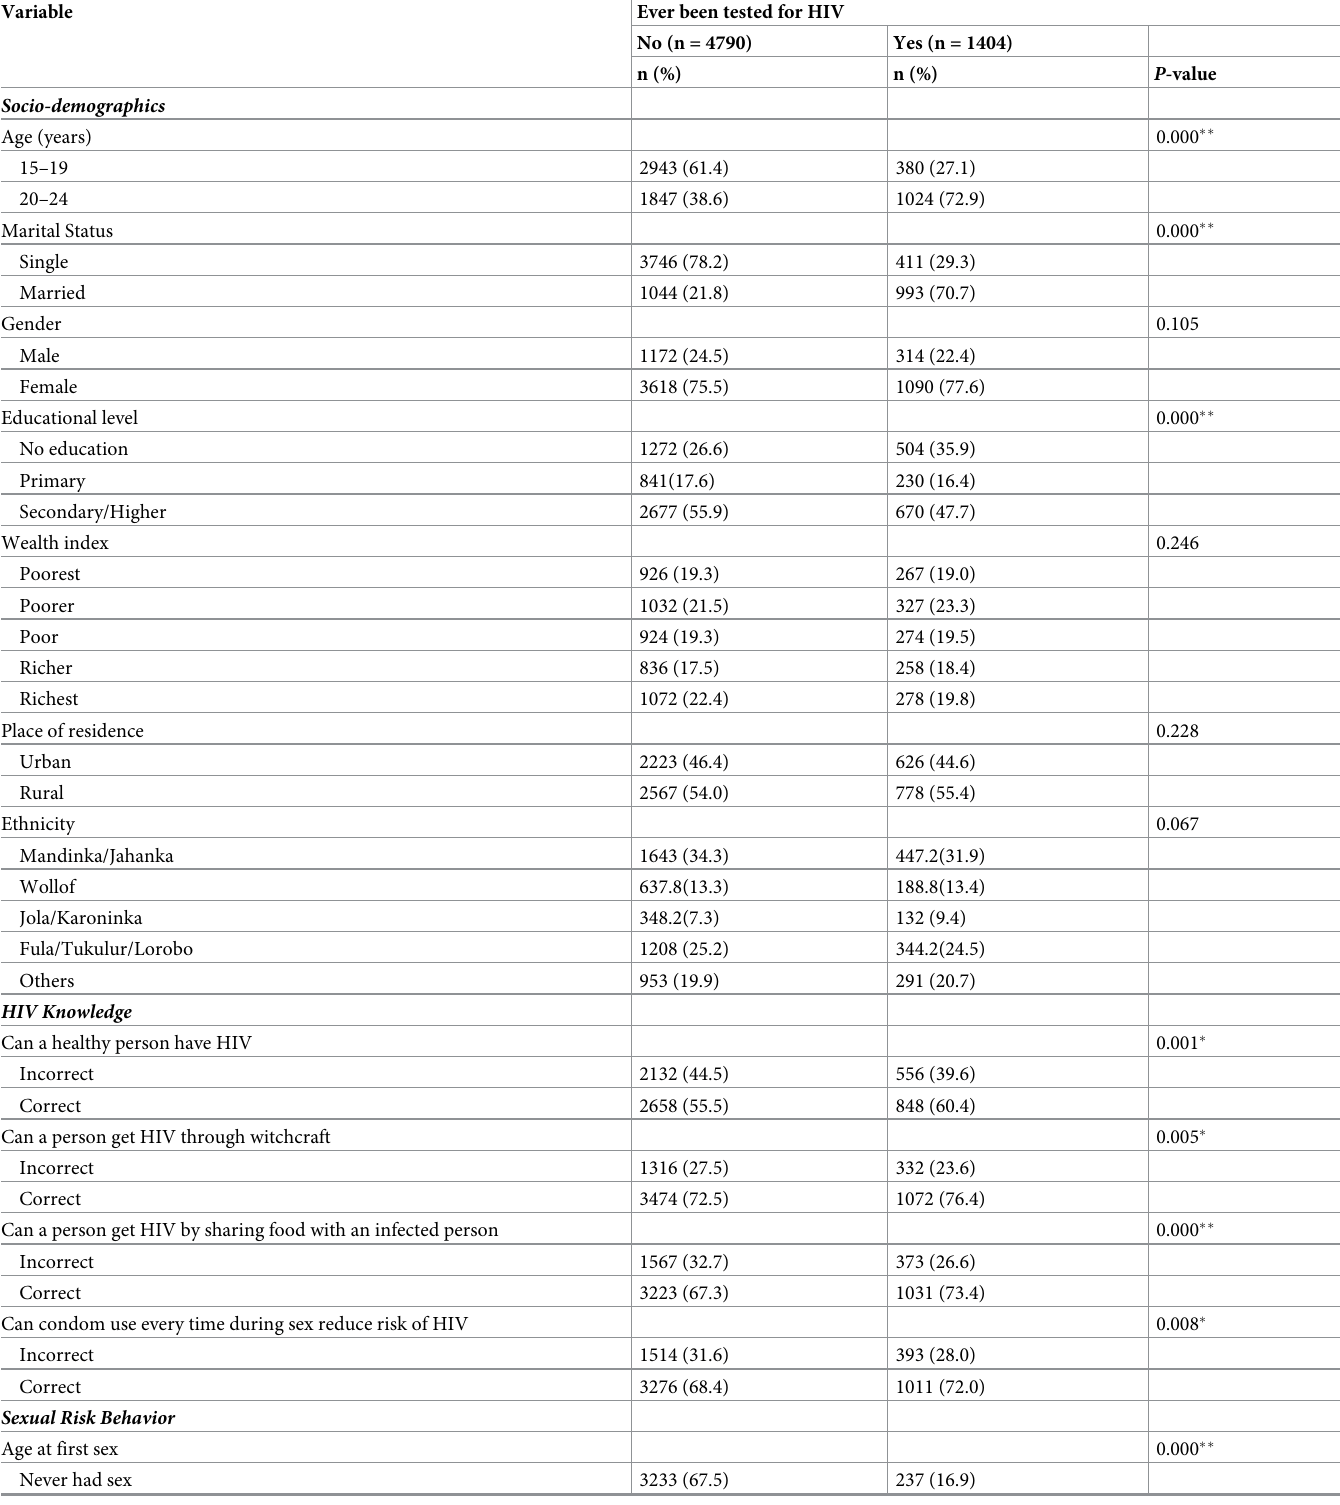
Table 2. Correlation of socio-demographic, HIV knowledge, behaviour and HIV testing (n =